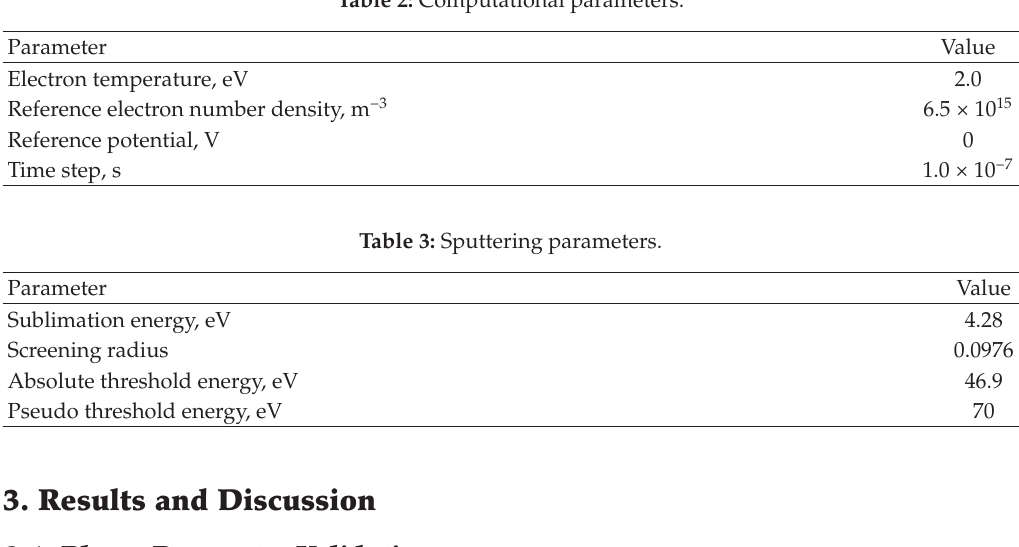
Table 2: Computational parameters.